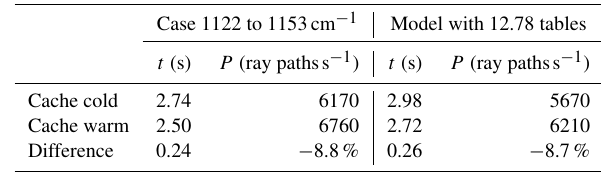
Figure 10. Linear scaling model to estimate GPU runtime: the GPU runtime per ray can be modeled as a linear function of the num- ber of active look-up tables. For each ray, a V100 GPU processing 32 channels needs approximately 16.4µs + 11.3µs per active gas table. On the newer A100 GPU, a slope of 8.1µs table − 1 is found (not shown). Table 2. GPU runtime measured and modeled for 16896 limb ray paths with 12.78 of 27 look-up tables active. In the unified mem- ory model, data are transferred into GPU memory on demand so a performance penalty is observed at first access (referred to as cold